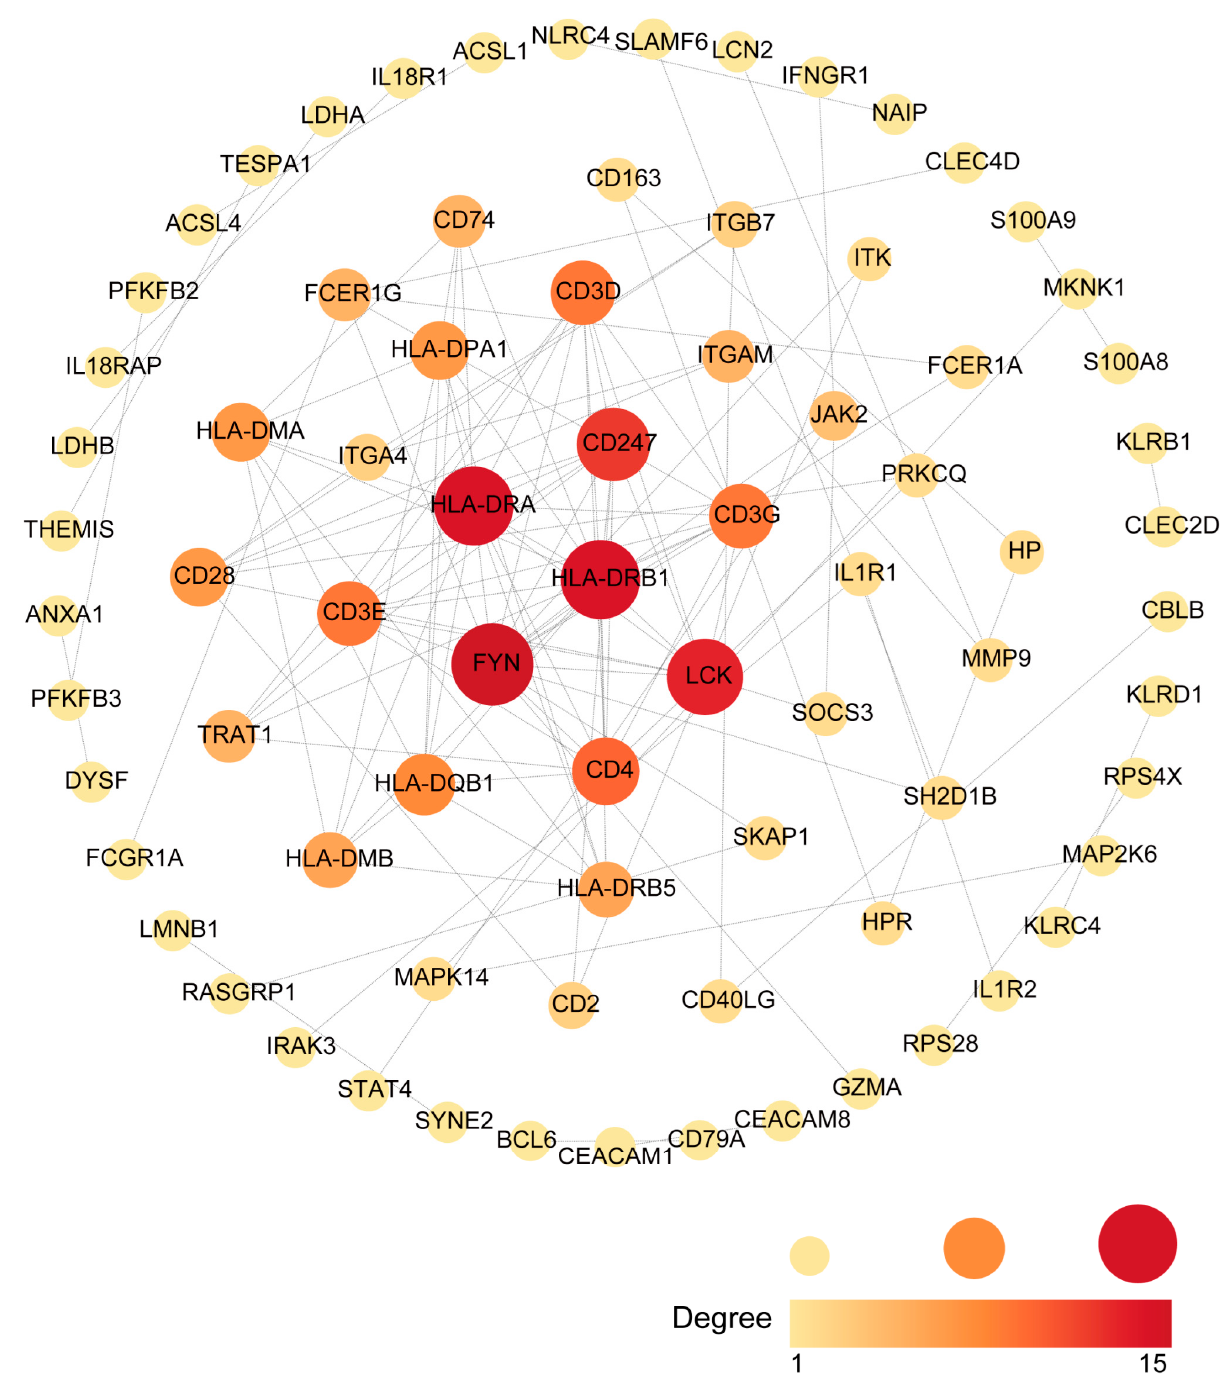
Figure 4. An analysis of the DEGs shared between COVID-19 and sepsis based on the PPI network. Cytoscape was used to visualize the PPI network generated by String. The darker the color, the more connections to the gene are identified. The larger size of the node suggests the higher connection degree of the gene.